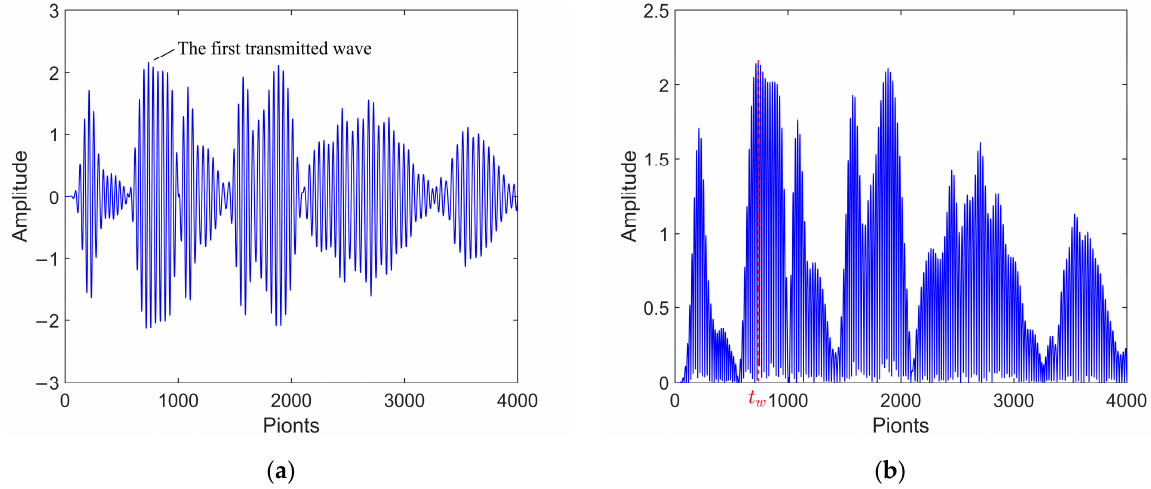
Figure 4. Clear water transmission wave data. ( a ) The original data; ( b ) the absolute value data.